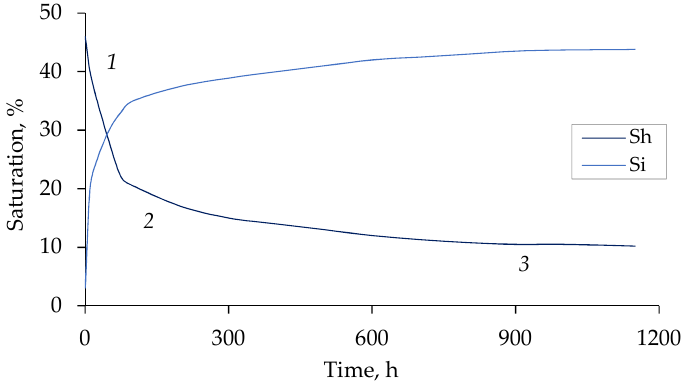
Figure 4. Time-dependent changes in methane hydrate ( S h ) and ice ( S i ) saturation in the sand 2 sample (W = 20%) at T = −6.5 ℃ after the pressure dropped to 0.1 MPa.